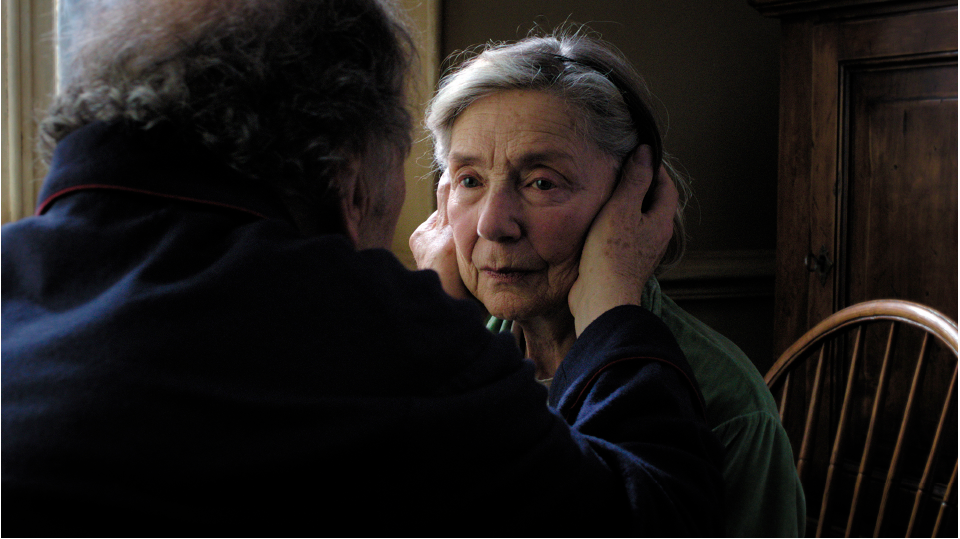
Figure 5. Anne begins to slip away.